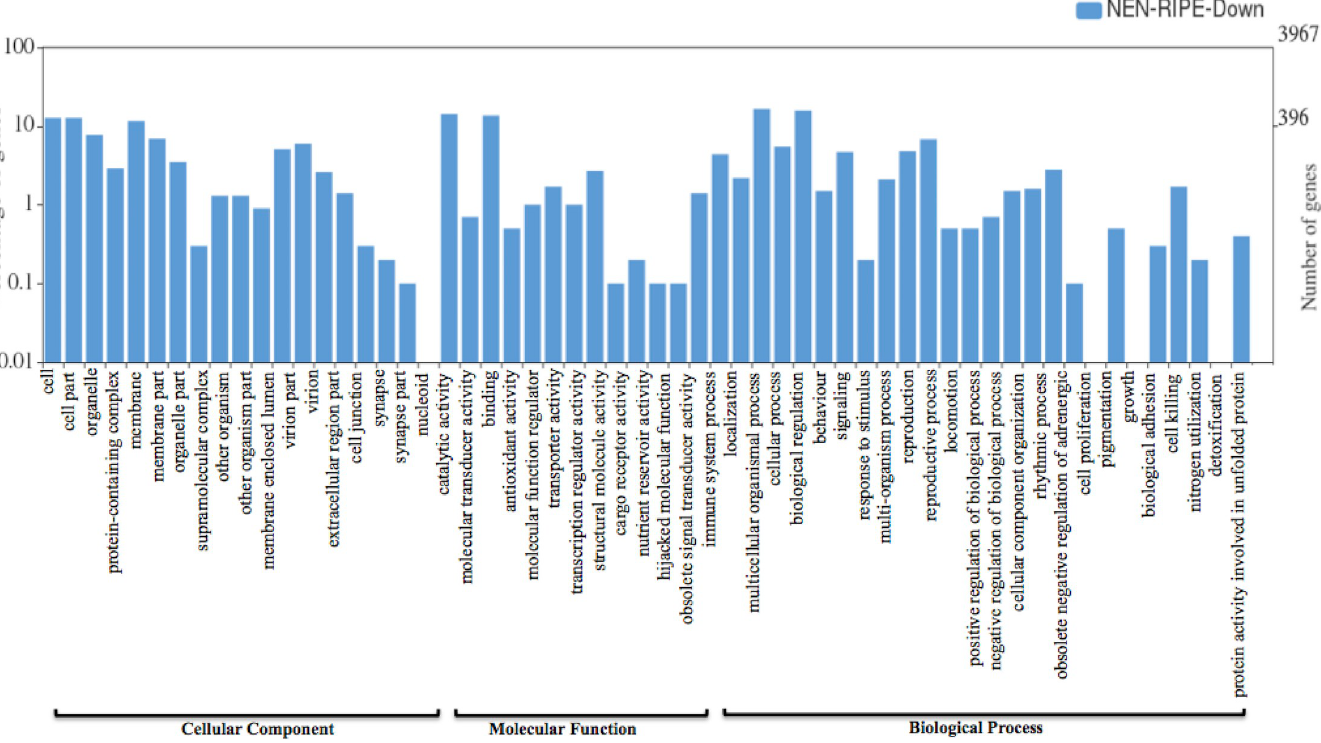
Fig 3. WEGO plot representing annotation and classification of differentially expressed genes in Nendran unripe fruit-pulp. X-axis (right) displaying selected GO terms of down-regulated genes and y-axis (left) displaying the percentage of genes.